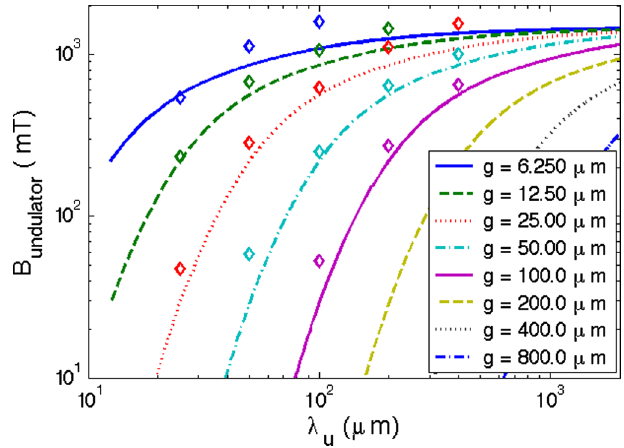
FIG. 5. Plot showing the scaling of the transverse magnetic flux density in the center of the undulator vs gap and period. ¼ (cid:2) ¼ (cid:2) ¼ 2 : 1 T are used. = 4 , W = 4 , and B Values of L y u y u sat Lines denote calculations and diamonds denote